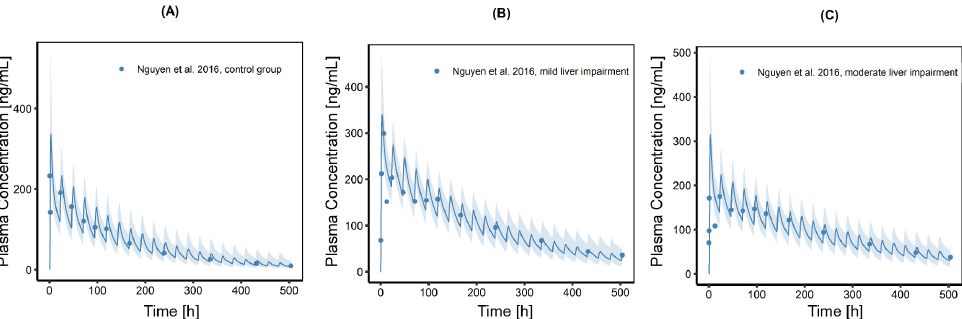
Figure 8. Population simulations ( n = 100) of CAB plasma concentration time profiles after a single dose of 60 mg CAB capsule to ( A ) the healthy control group, ( B ) patients with mild liver impairment and ( C ) patients with moderate liver impairment. Blue dots indicate mean observed plasma concentrations, the blue line represents the population simulations geometric mean of the predicted plasma concentrations; the shaded areas represent the predicted population geometric SD.